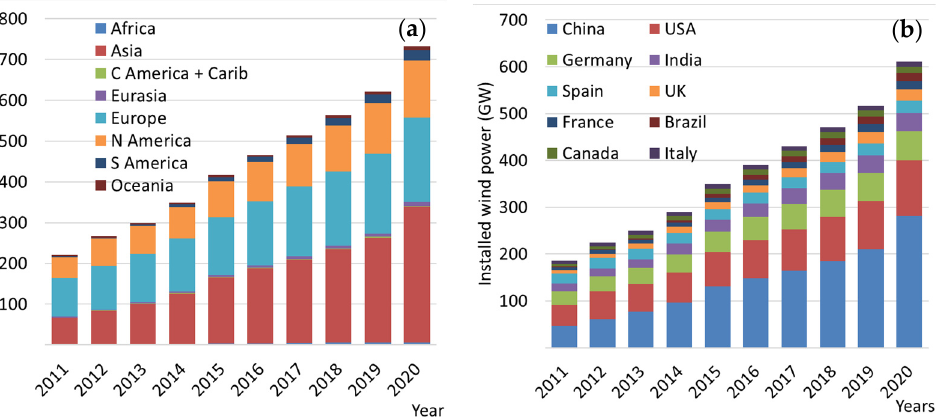
Figure 5. Installed global wind power capacity in GW: ( a ) divided by continents, ( b ) divided by the top ten countries for 2020.